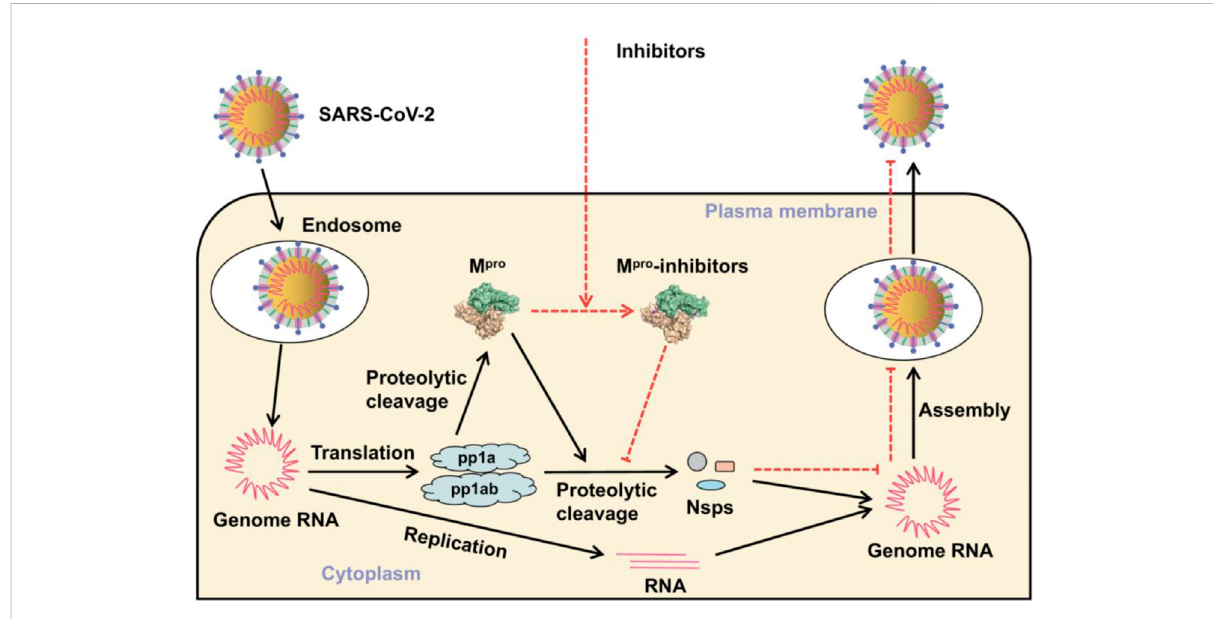
FIGURE 2 Position of the inhibitor in the prevention of SARS-CoV-2 replication (Mengist et al.,